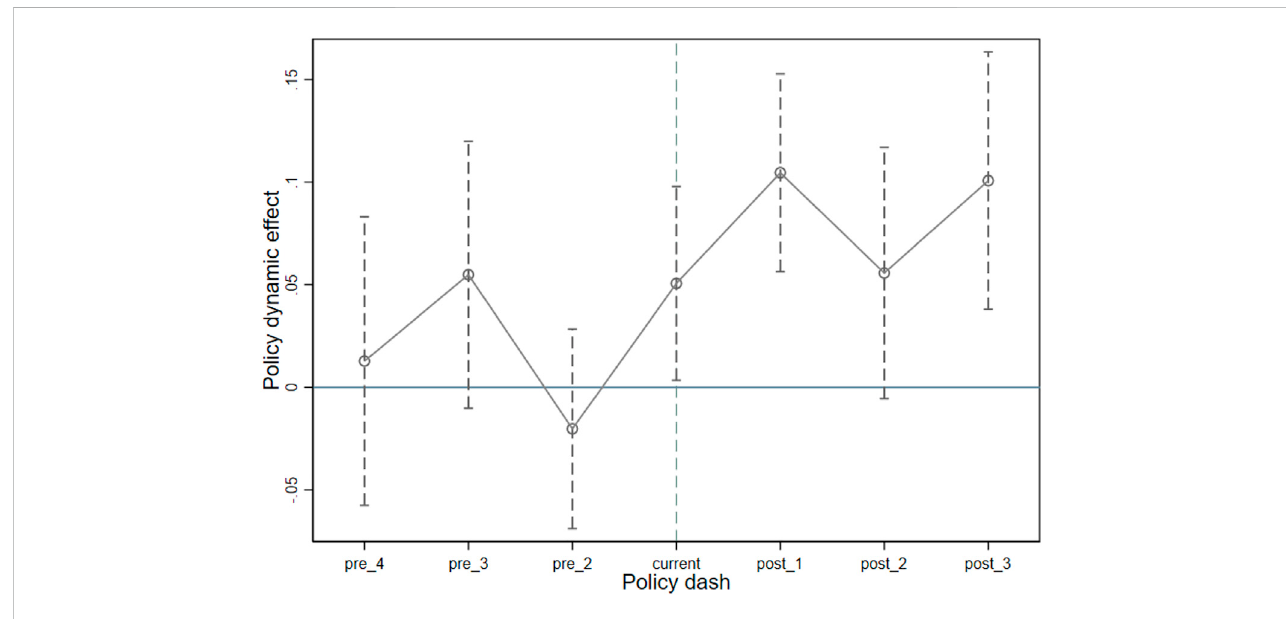
FIGURE 1 Parallel trend test from 2008 to 2015.